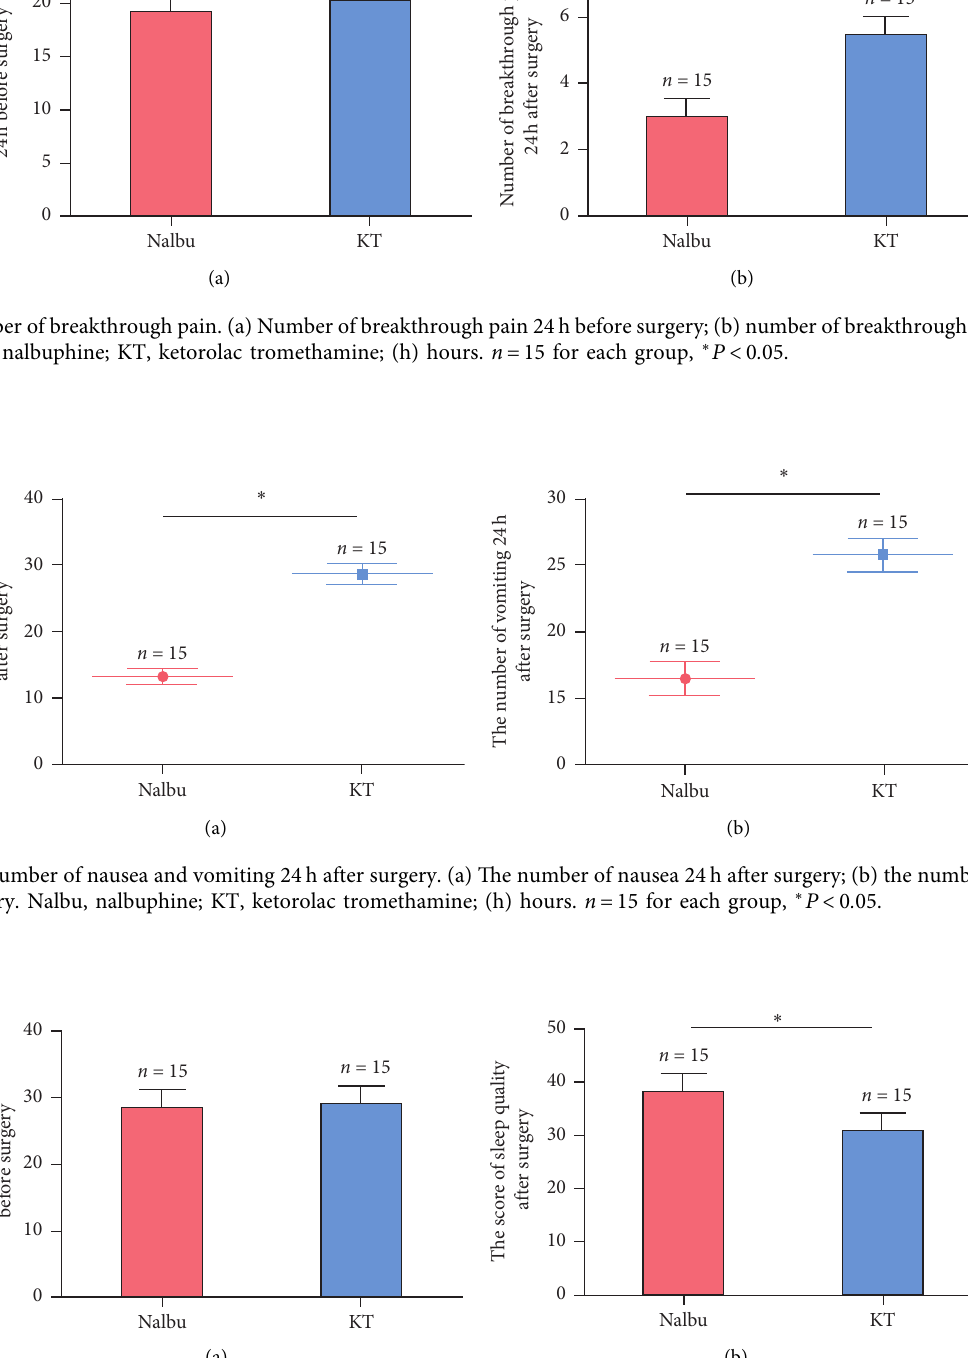
Nalbu Figure 7: The scores from the Self-Rating Scale of Sleep (SRSS) between two groups. (a) The score of sleep quality before surgery; (b) the score of sleep quality after surgery. Nalbu, nalbuphine; KT, ketorolac tromethamine. n � 15 for each group, ∗ P < 0 .